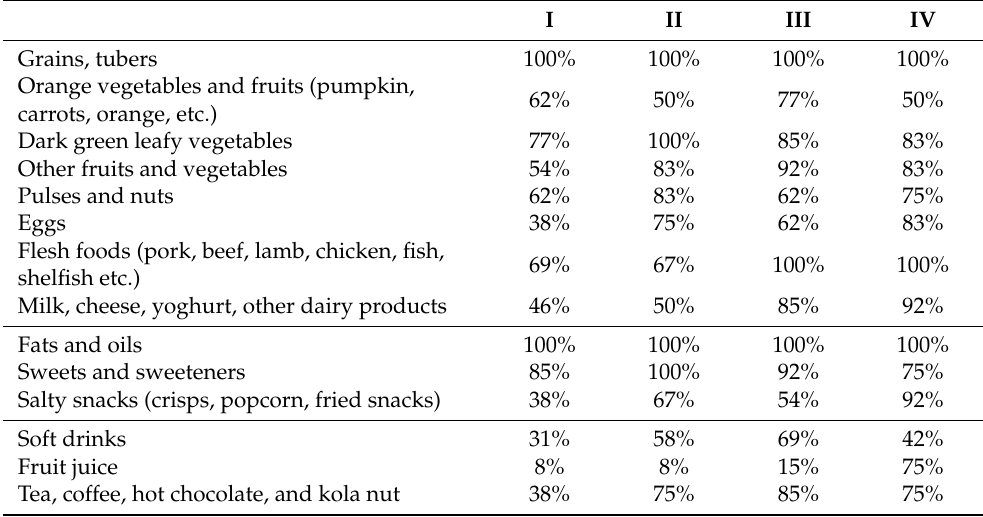
Table 6. Food groups consumed by children in Oyo State across different wealth groups in the 2 days prior to the survey (I poorest–IV richest)